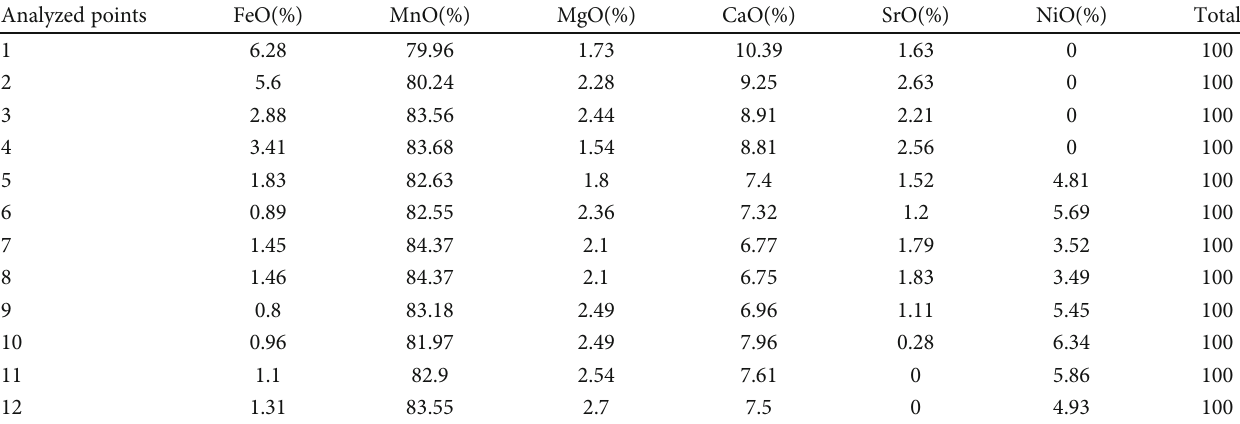
Table 2: Chemical composition of black tree-shaped structures in